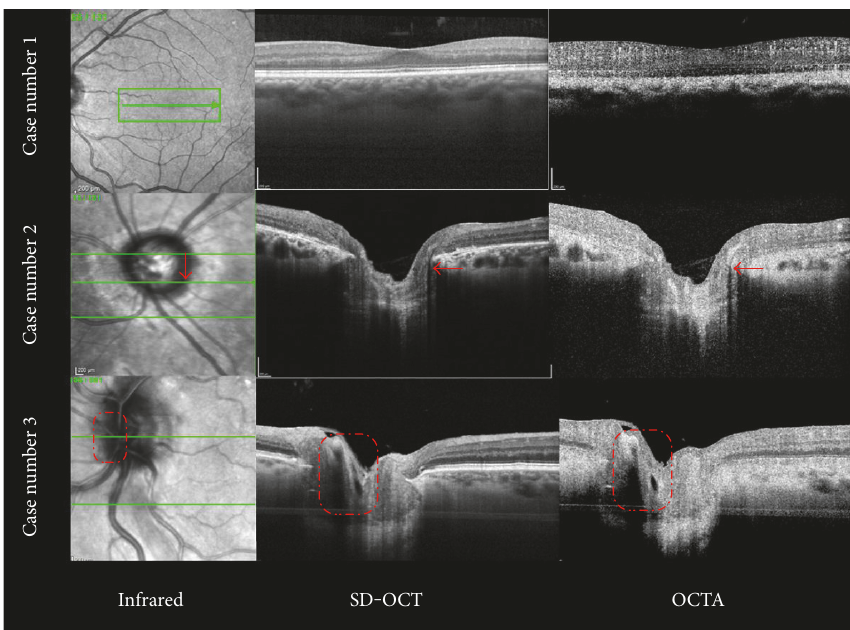
Figure 2: Orientation of vessels according to the type of scanning laser used. The inner and outer neuron layers and the inner and outer photoreceptor segments appear dark on both SD-OCT and OCTA because of the “ coherence ” of the scanning laser. Similarly, if blood fl ow is parallel to the orientation of the scanning laser, for example, in the optic disc region, it becomes dark on OCT and OCTA (red arrows and red dash-dotted boxes). OCTA: optical coherence tomography angiography; SD-OCT: spectral-domain optical coherence tomography.